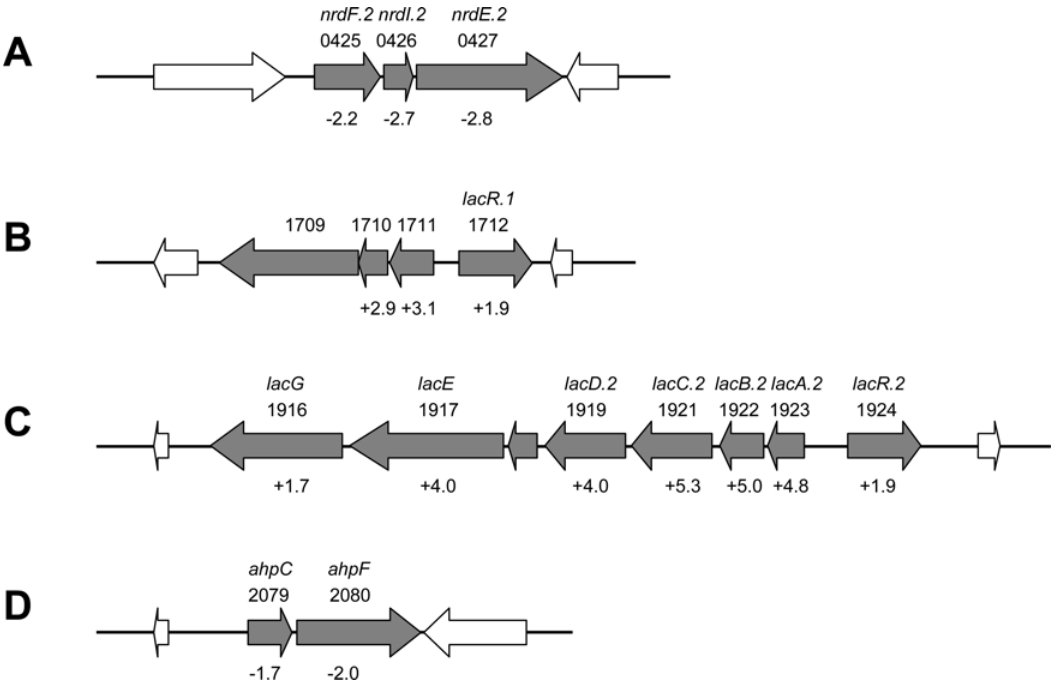
Figure 7. Genetic organization of four PerR-dependent predicted operons in strain 003Sm. The ribonucleotide reductase system (A), the putative lactose/galactose PTSs SPy1709-SPy1711 (B) and SPy1923-SPy1916 (C) with their putative cognate regulators in opposite orientation, and the alkyl hydroperoxidase/alkyl hydroperoxide reductase AhpCF (D) loci are shown. The genes and ORF numbers for each locus in M-type 1 GAS strain SF370 [32] are indicated. Numbers below the genes indicate relative expression levels (fold-change) in wild-type strain 003Sm compared to perR mutant strain 003Sm perR D recorded in the microarray experiments.